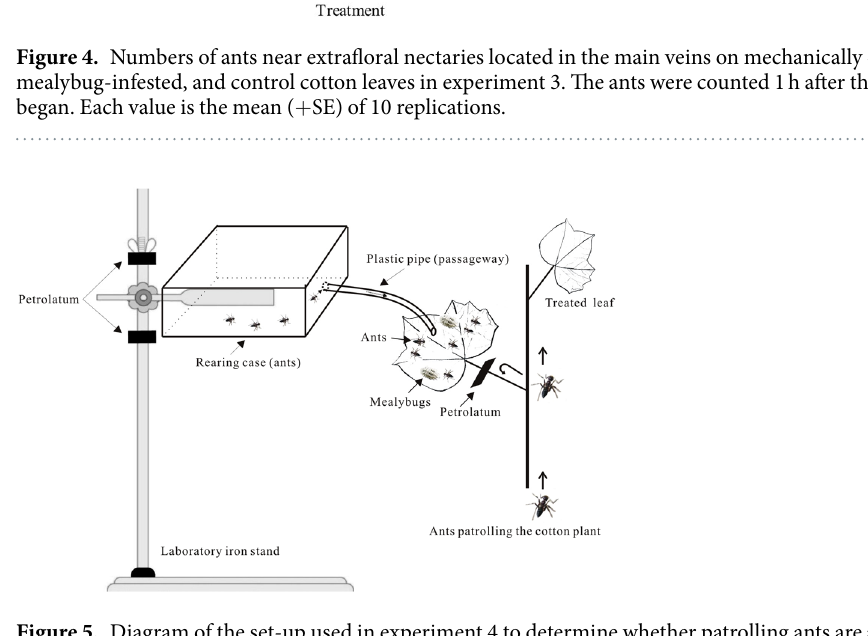
in the figure, the patrolling ants could move up the plant but could not contact mealybugs or tending ants because the petioles were coated with petrolatum. The number of patrolling ants per plant was determined at the indi- cated time intervals. The effects were not statistically significant for treatment (MA2, MA, and CK; F 2,60 = 2.47, P = 0.093), observation time ( F 3,60 = 2.48, P = 0.070), or the interaction between treatment and observation time ( F 6,60 = 2.22, P = 0.053) (Fig. 6). Effects of the tending of mealybugs by ants on volatiles emitted from plants (experiment 5). When volatiles were collected from cotton plants subjected to treatment (CK, M2, or MA2), a total of 13 major volatile compounds were detected; 9 in the CK (without mealybugs or ants), 11 in M2 (with 60 mealybugs per plant), and 13 in MA2 (with 60 ant-tended mealybugs per plant) (Fig. 7). Mealybugs caused the emission of cedrol whether or not the mealybugs were tended by ants ( F = 23.16, df = 14, P < 0.001). When cotton plants were infested with mealybugs, methyl nicotinate and β -curcumene emissions tended to increase, whereas dode- cane and p-cymene emissions tended to decrease, but the rate of emission did not significantly differ from that in the control. Relative to the control, MA2 significantly increased the emission of p-cymene ( F = 3.92, df = 14, P = 0.049), β -curcumene ( F = 12.70, df = 14, P = 0.0011), cedrol ( F = 23.16, df = 14, P < 0.001), and one uniden- tified compound ( F = 11.17, df = 14, P = 0.002), but significantly decreased the emission of methyl nicotinate ( F = 3.92, df = 14, P = 0.049) and dodecane ( F = 4.43, df = 14, P = 0.04). Methyl salicylate (MeSA) and one uni- dentified compound were emitted when ants tended mealybugs (MA2) but not when ants did not tend mealybugs (M2).